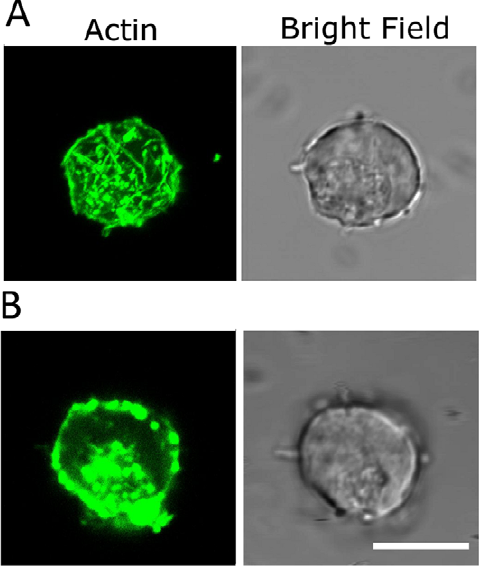
Figure 16. Typical confocal and DIC images of F-actin staining of Cytochalasin – D treated neural progenitor cells. Note the absence of actin staining in the filopodial projections of the neural progenitor in A) even though there are prominent F-actin filaments visible within the cell body (See Movie S10 for a 3D reconstruction). The neural progenitor in B) shows not only an absence of F-actin staining in the filopodial projections but a significant disruption of cytoskeletal F- actin as well. Scale bars denote 10 m m.